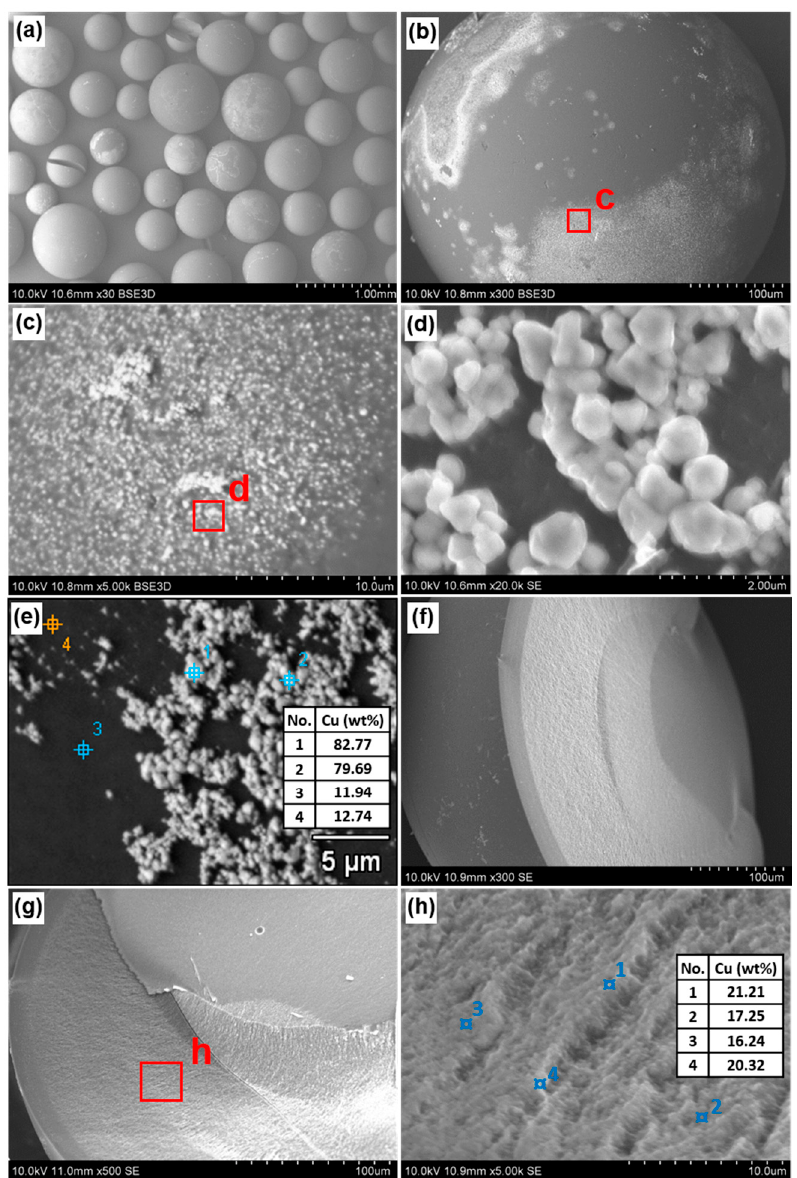
Figure 8. SEM images and EDS analysis of the M/An/Cu-2 ( a )–( e ) surface, ( f )–( h ) inside.